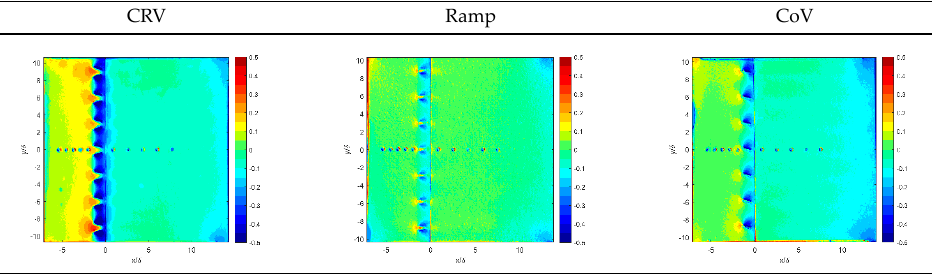
Figure 8. Global surface pressure pa tt ern for M = 0.83 and h* = 1.0. The C p distributions ( h* = 0.2, 0.5, and 1.0) for M = 0.83 and y* = 0 that were measured